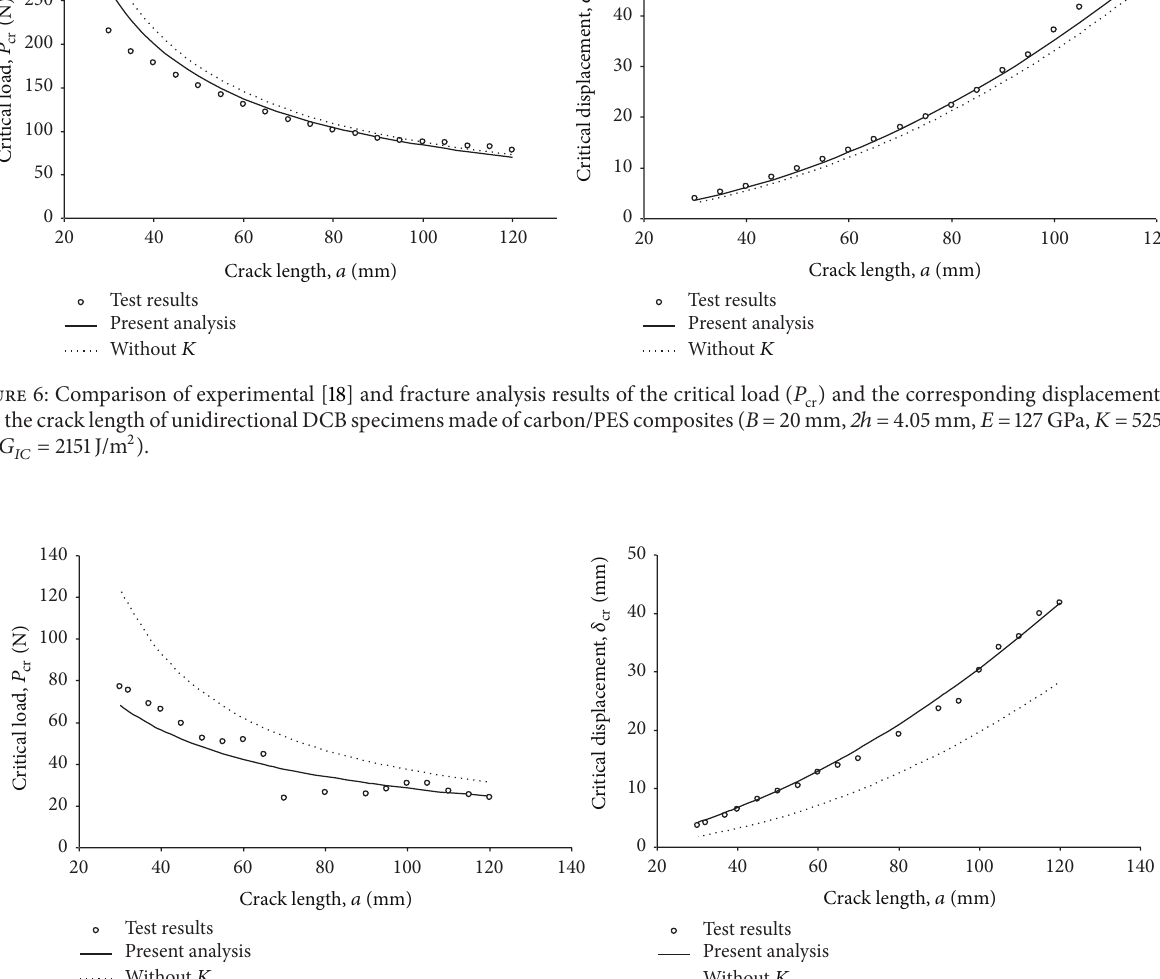
Figure 7: Comparison of experimental [19] and fracture analysis results of the critical load (𝑃 with the crack length of unidirectional DCB specimens made of carbon/epoxy composites ( 𝐵 = 30 mm, 2 ℎ = 3 mm, 𝐾 = 37 Nm, 𝐸 = 150GPa, and 𝐺 𝐼𝐶 = 364 J/m 2